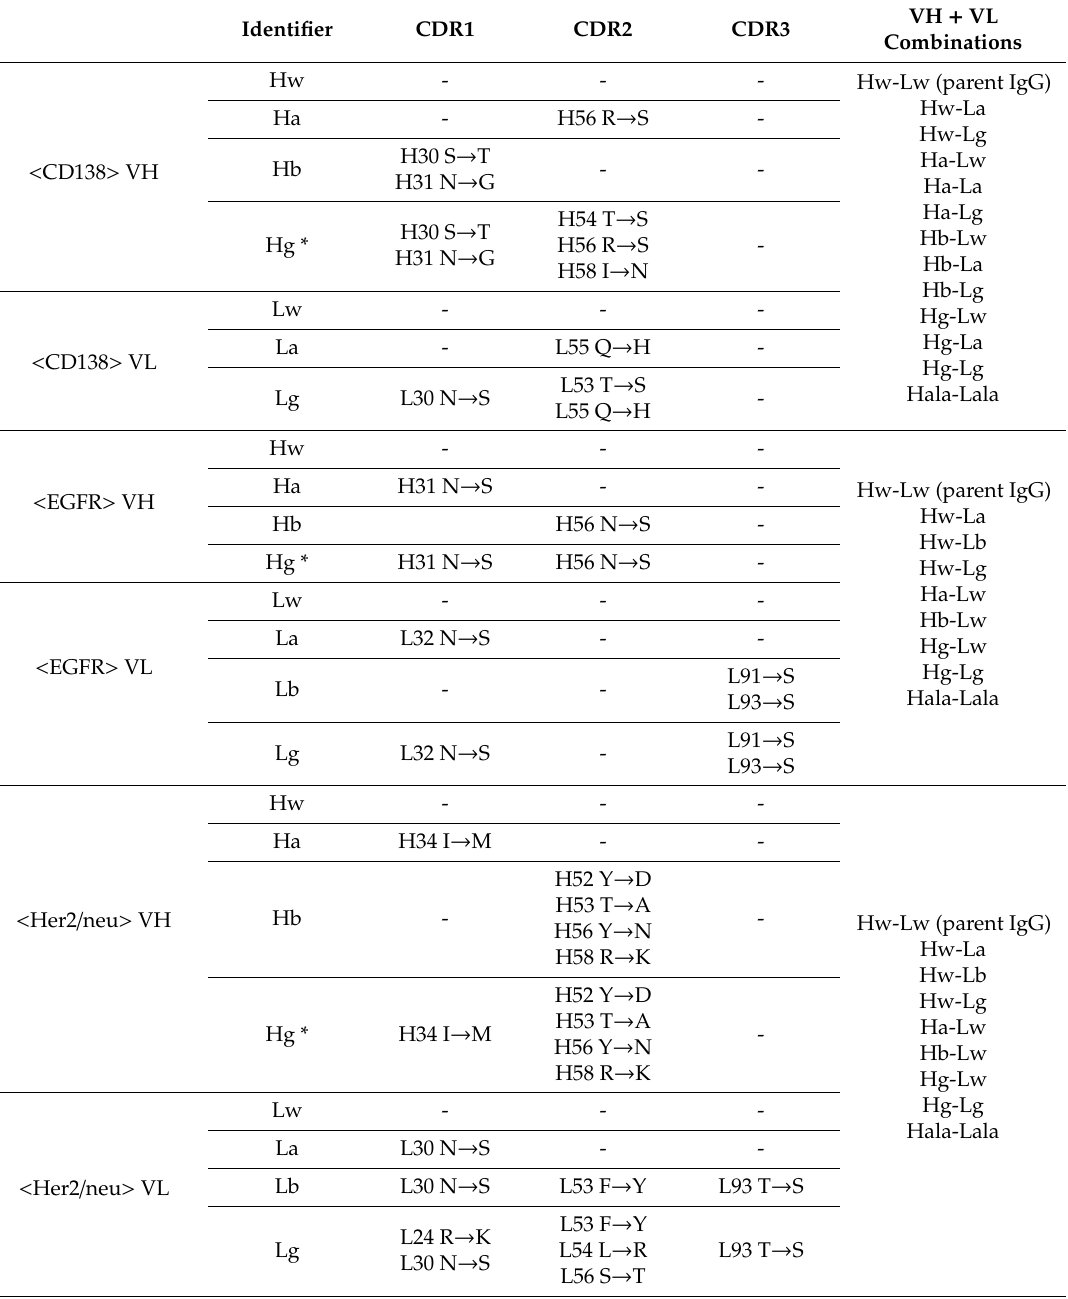
Table 1. B2G variants in VH and VL of di ff erent antibodies. Positions are defined in accordance with the Kabat numbering scheme. * ‘germline’ of VH can be defined only for CDR1 and CDR2 because H-chain VDJ rearrangement is too complex to unambiguously call the composition of the original VDJ-event and to di ff erentiate that from potential additional hypermutations placed on top of that. Sequences that do not deviate from the original input antibody are termed Hw and Lw (‘wild-type; parental IgG’), Sequences that have CDRs completely reverted to germline (except for H-CDR3) are termed Lg and Hg* (‘germline’). Sequences that have those CDR positions (of Lg and Hg) mutated to alanine are termed